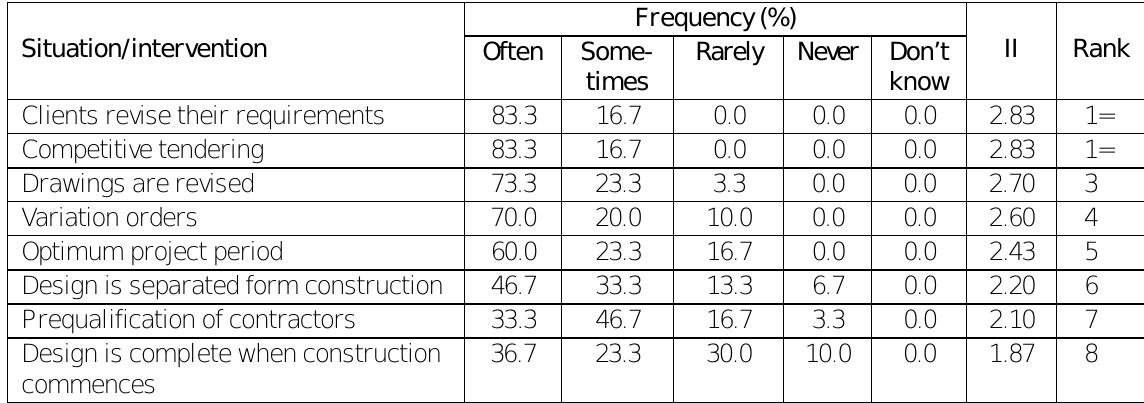
Table 5: Frequency at which PMs achieve/encounter / use various procurement related